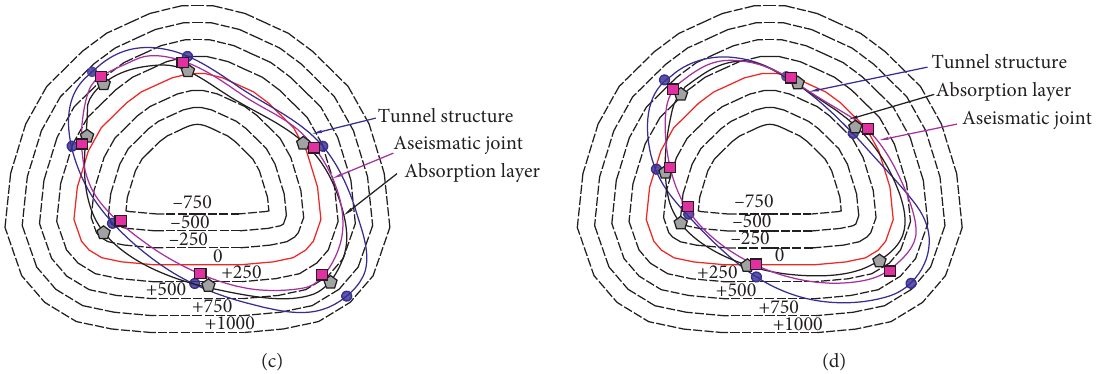
Figure 12: Bending moment distributions at 9.8 s and 12.7s. (a) Left tunnel at 9.8 s. (b) Right tunnel at 9.8 s. (c) Left tunnel at 12.7s. (d) Right tunnel at 12.7 s.